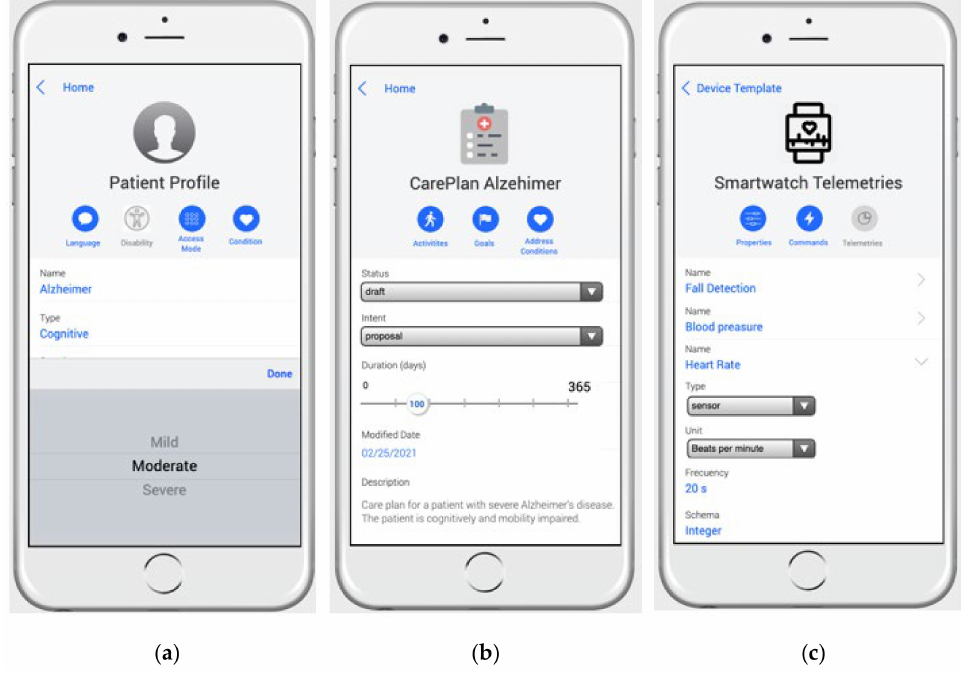
Figure 6. Web app admin of MoSIoT. ( a ): Patient Profile edition screen; ( b ): CarePlan Alzheimer edition screen; ( c ): Smartwatch Telemetries edition